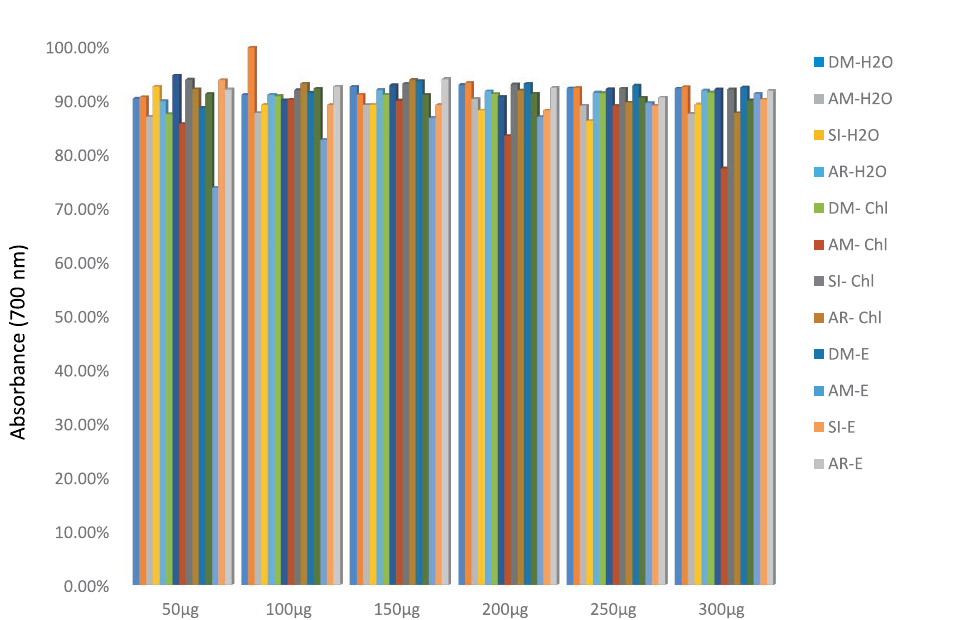
Fig. 5. Iron reducing activity of medicinal plants chosen for this study by FRAP assay. DM-H O – aqueous extract of Datura metel , AM-H O – aqueous extract of Aegle marmelos , SI-H O – aqueous extract of Saraca 2 2 2 indica , AR-H2O – aqueous extract of Annona reticulata , DM-chl – chloroform extract of Datura metel , AM-chl – chloroform extract of Aegle marmelos , SI-chl – chloroform extract of Saraca indica , AR-chl – chloroform extract of Annona reticulata , DM-E– ethanol extract of Datura metel , AM-E– ethanol extract of Aegle marmelos , SI-E– ethanol extract of Saraca indica , AR- -E– ethanol extract of Annona reticulata